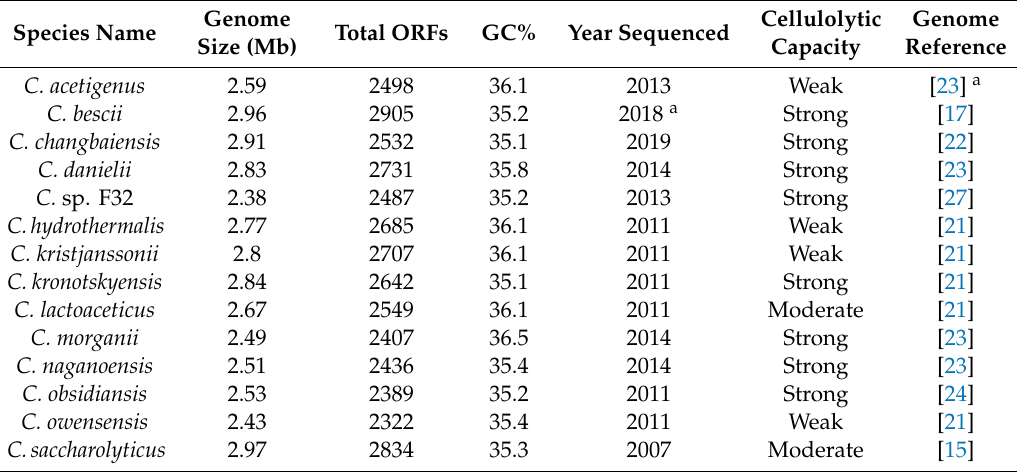
Table 1. Sequenced members of the genus